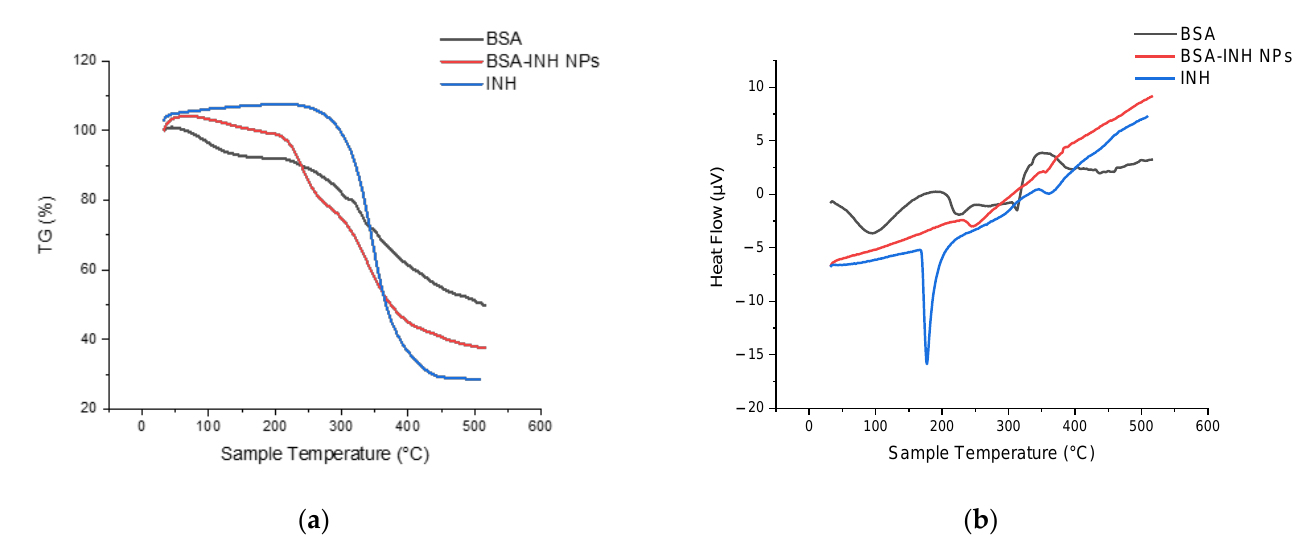
Figure 5. Thermogravimetric ( a ) and differential scanning calorimetry ( b ): INH; BSA; BSA-INH NPs.